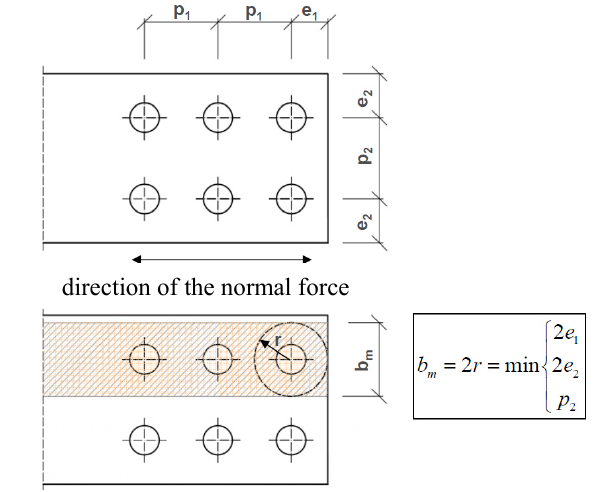
Figure 7: Definition of the relevant pane width b m